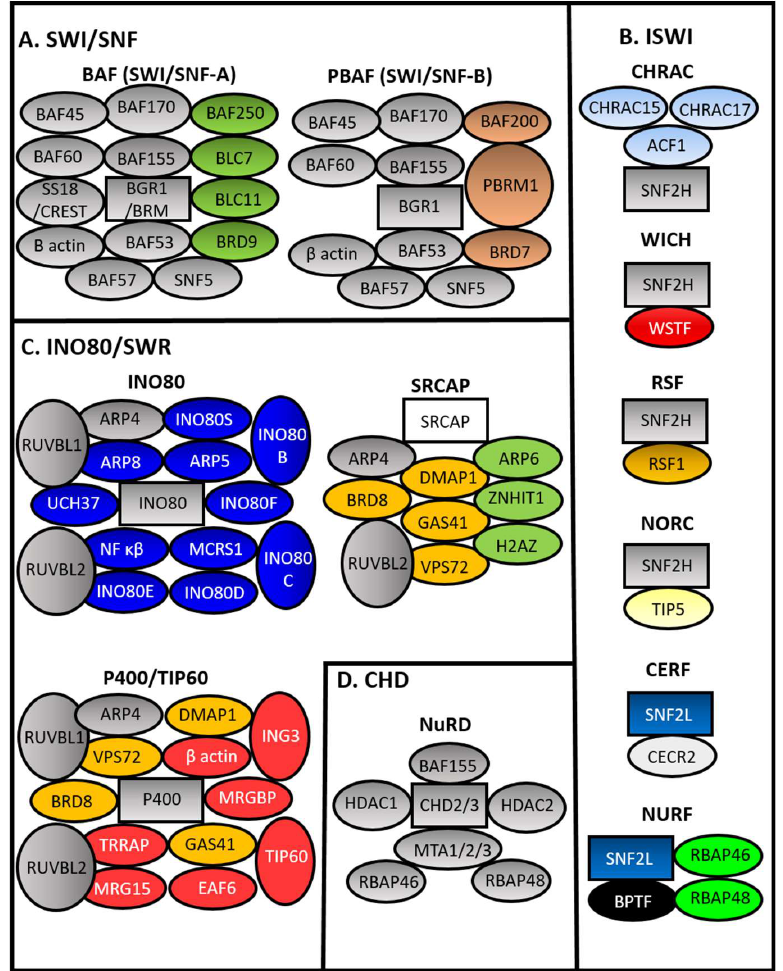
Figure 2. Mammalian Chromatin remodeler complexes. Chromatin Remodeler Complexes (CRCs) from the four subfamilies of CRCs based on ATPase domains are shown. ( A ) SWItch/Sucrose Non-Fermentable (SWI/SNF), ( B ) imitation SWI (ISWI), ( C ) inositol-Requiring 80/Sick with RSC (INO80/SWR), and ( D ) Chromodomain Helicase DNA-binding CHD (CHD). Rectangles represent ATPase domain. Brahma (BRM) BRM Related Gene 1 (BRG1), BRG1/BRM Associated Factor (BAF), Polybromo Associated BAF Complex (PBAF), Snf2 Related CREBBP Activator Protein (SRCAP), Tat Interacting Protein 60 (TIP60), Nucleosome Remodeling Deacetylase (NuRD), Chromatin Accessibility Complex (CHRAC), Remodeling And Spacing Factor (RSF), Nucleolar Remodeling Complex, Cat Eye Syndrome Chromosome Region Candidate 2 (CERC2), CECR2 Containing Remodeling Factor (CERF), Nucleosome Remodeling Factor (NURF), B-Cell CLL/Lymphoma (BCL), Bromodomain Containing (BRD), Polybromo 1 (PBRM1), RuvB Like AAA ATPase (RUVBL)(RVB), Actin related protein (ARP), Ubiquitin C-Terminal Hydrolase L5 (UCH37 Microspherule Protein 1 (MCRS1), Nuclear Factor Kappa B Subunit (NF κβ), DNA Methyltransferase 1 Associated Protein 1 (DMAP1), Glioma-Amplified Sequence 41 (GAS41), Vacuolar Protein Sorting 72 (VPS72), Zinc Finger HIT-Type Containing 1 (ZNHIT1), H2A Histone Family Member Z (H2AZ), Transformation/Transcription Domain Associated Protein (TRRAP), MORF-Related Gene 15 Protein (MRG15), MRG Domain Binding Protein (MRGBP), Esa1 Associated Factor 6 (EAF6), Inhibitor Of Growth Family Member 3 (ING3), Histone Deacetylase, (HDAC), Metastasis Associated (MTA), Retinoblastoma-Binding Protein (RBAP), ATP-Dependent Chromatin Assembly Factor 1 (ACF1), Sucrose Nonfermenting Protein 2 Homolog (SNF2H), Sucrose Nonfermenting 2-Like Protein 1 (SNF2L), Williams Syndrome Transcription Factor (WSTF), and Bromodomain PHD Finger Transcription Factor (BPTF).